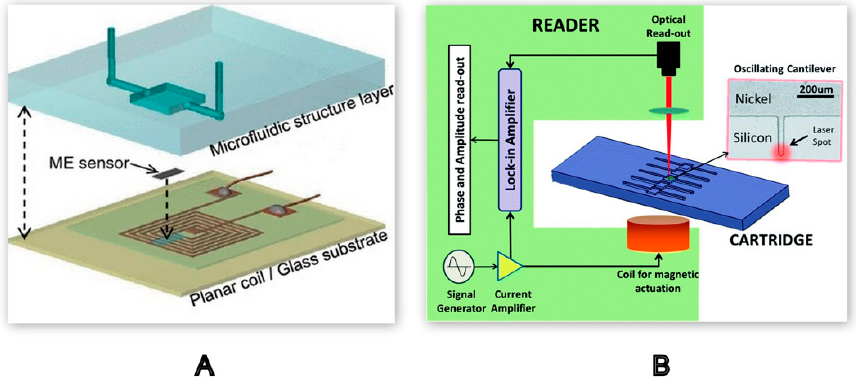
Figure 10. ( A ) Placement of components in a microfluidic device working on the principle of resonant frequency [80]. ( B ) Working set-up of the microfluidic cartridge. Taken with permission from [43].